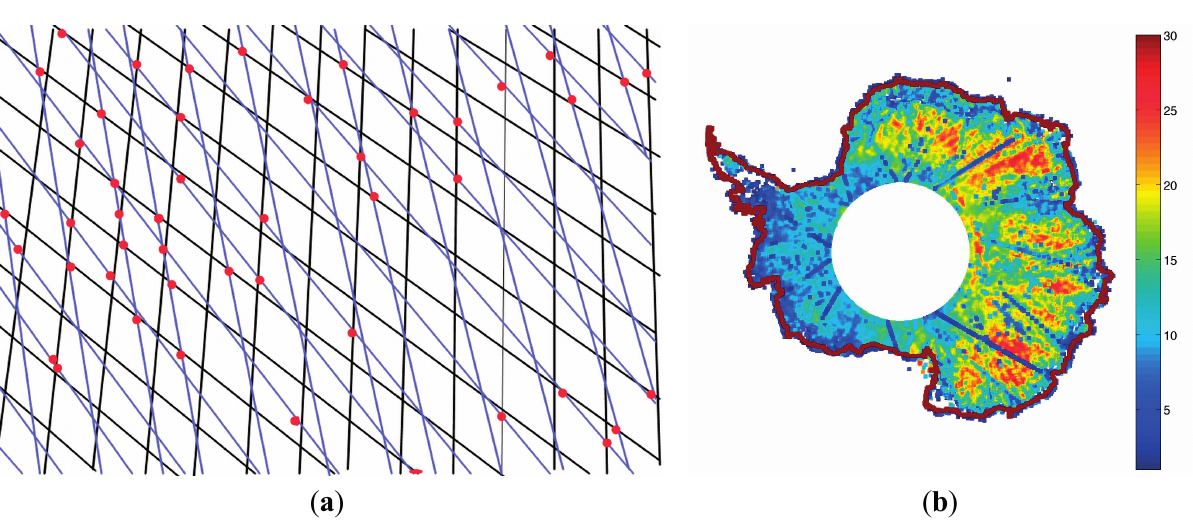
Figure 2. ( a ) Crossover analysis principle: the red dots are the locations where black tracks (ICESat) meet blue ones (ENVISAT), the measurement is thus given at the same location and can be processed and compared. This image covers the Ronne Ice Shelf area, the scale is 1/200 (1 cm = 50 km). The X-axis is the longitude and the Y-axis the latitude; ( b ) map of the number of same crossover points for the whole period, useful to assess the reliability of our